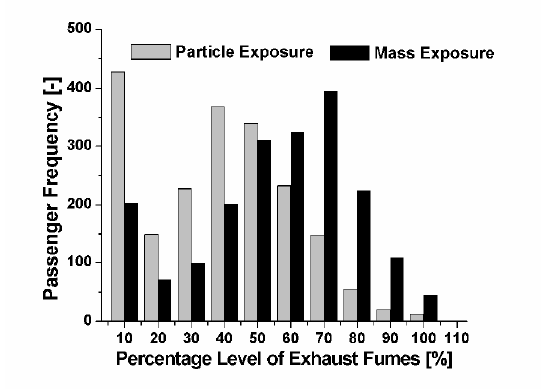
Figure 5 : This histogram representation reveals the number of passengers exposed partially or entirely to bus fumes. The dark-colored section highlights particle number concentration, whereas the light-shaded portion the corresponding mass exposure concentration.